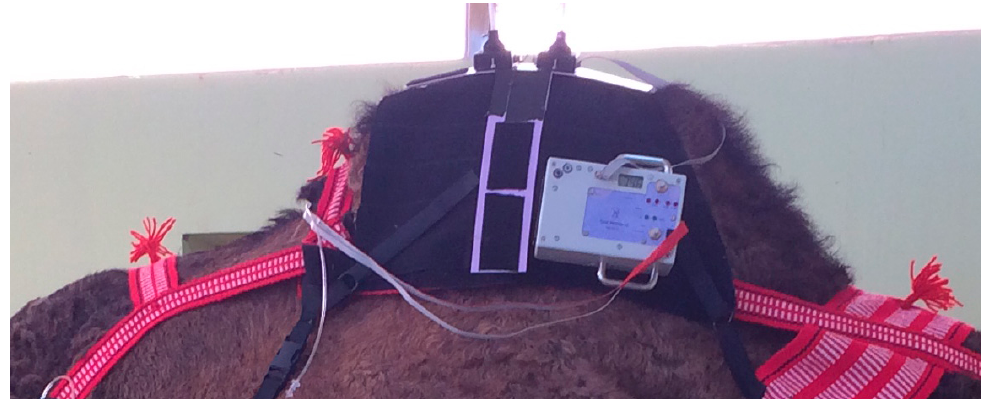
Figure 4. Cuboid thermal unit mounted on a camel’s hump.